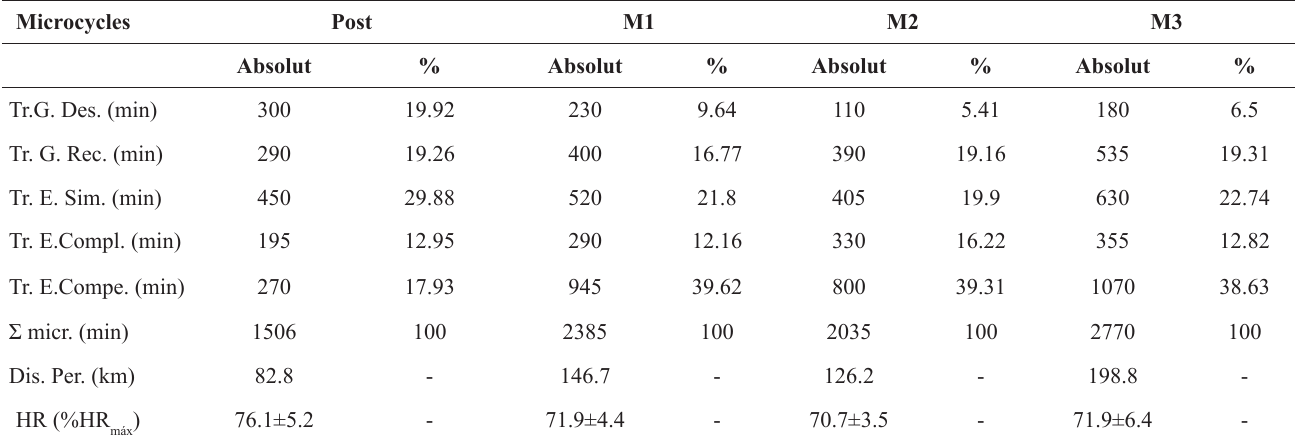
) for each phase of training (training meso- máx